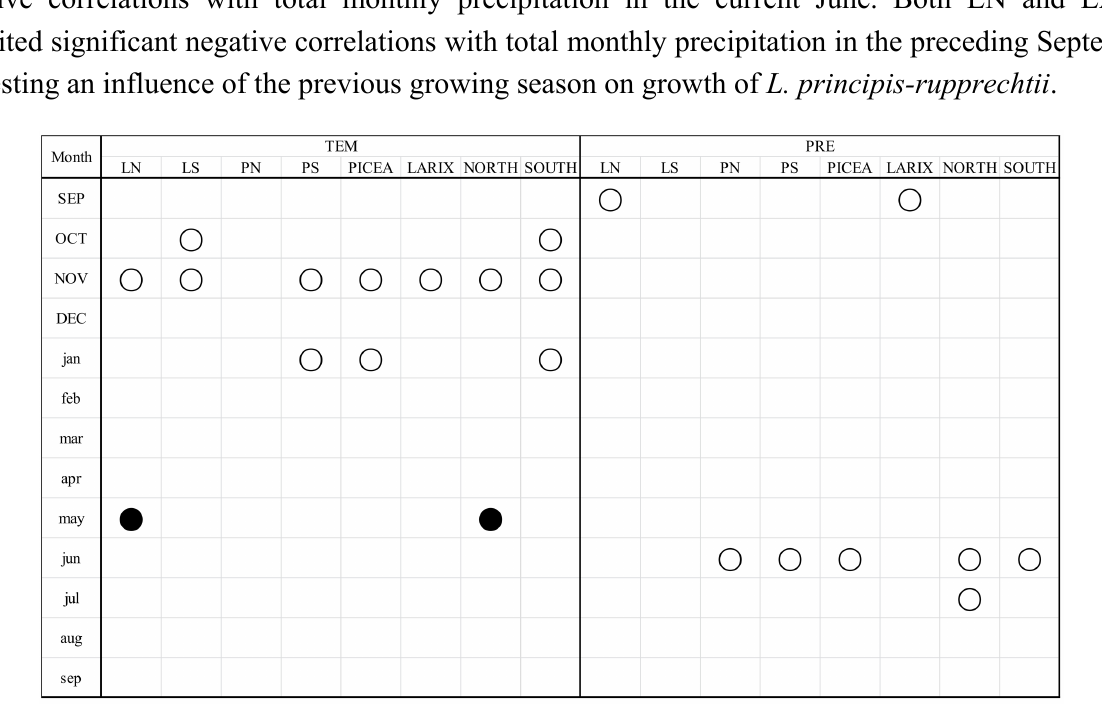
Figure 3. Pearson correlation coefficients between tree-ring chronologies and monthly climate data (monthly mean temperature, TEM, and total monthly precipitation, PRE). The white circles represent significant negative correlation, whereas black circles represent significant positive correlation. Significant level is 95% ( p ≤ 0.05). The capitalized months denote months belonging to the previous